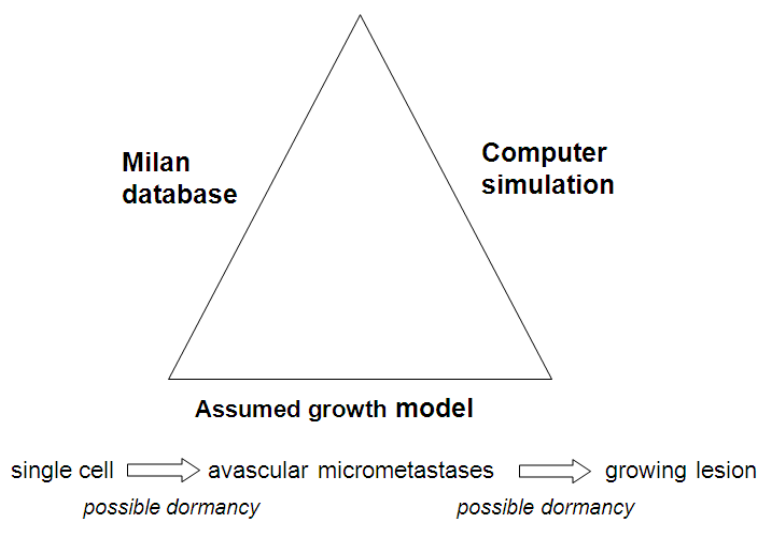
Figure 2. Overview of the algorithmic approach to the analysis of the Milan